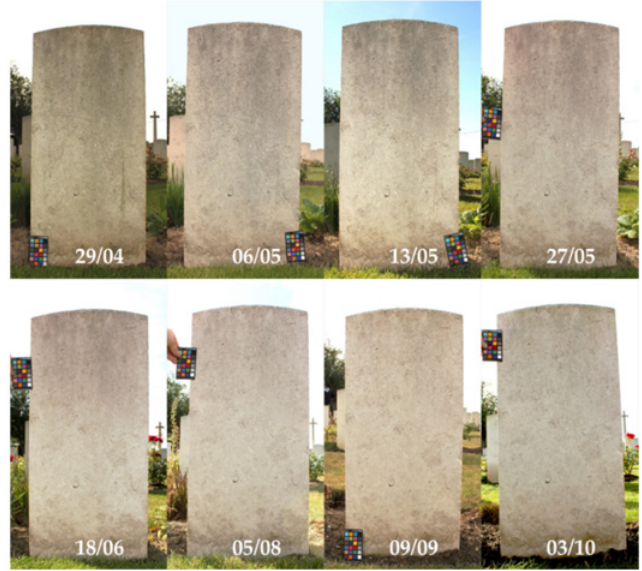
Figure 7. Evolution of grey-black biofilm in streaks and green biofilm (Site B). Both products seemed effective, and after analysing CD values and visual observations, no clear differences between treatments with different products appeared. Green biofilms disappeared relatively fast after the application of both products, whereas more intense green streaks disappeared in the first weeks after application. Grey to black streaks strongly diminished or completely disappeared in the longer term, which was strongly visible after three months. The lichen degraded in the first weeks after application, and thalli were washed away after a few months. It is assumed that the enzyme-based products negatively affect the microorganisms (resulting in a decrease in chlorophyll, hence CD). Long-term exposure to rain spells acts as natural washing, removing significant amounts of withered organisms and EPS from the surface. This resulted in a visual reduction in biofouling. The stone itself was macroscopically unaffected by the treatment (white, etched zones remained the same), and the treatment did affect other types of discolouration, such as the darkening at the base of the